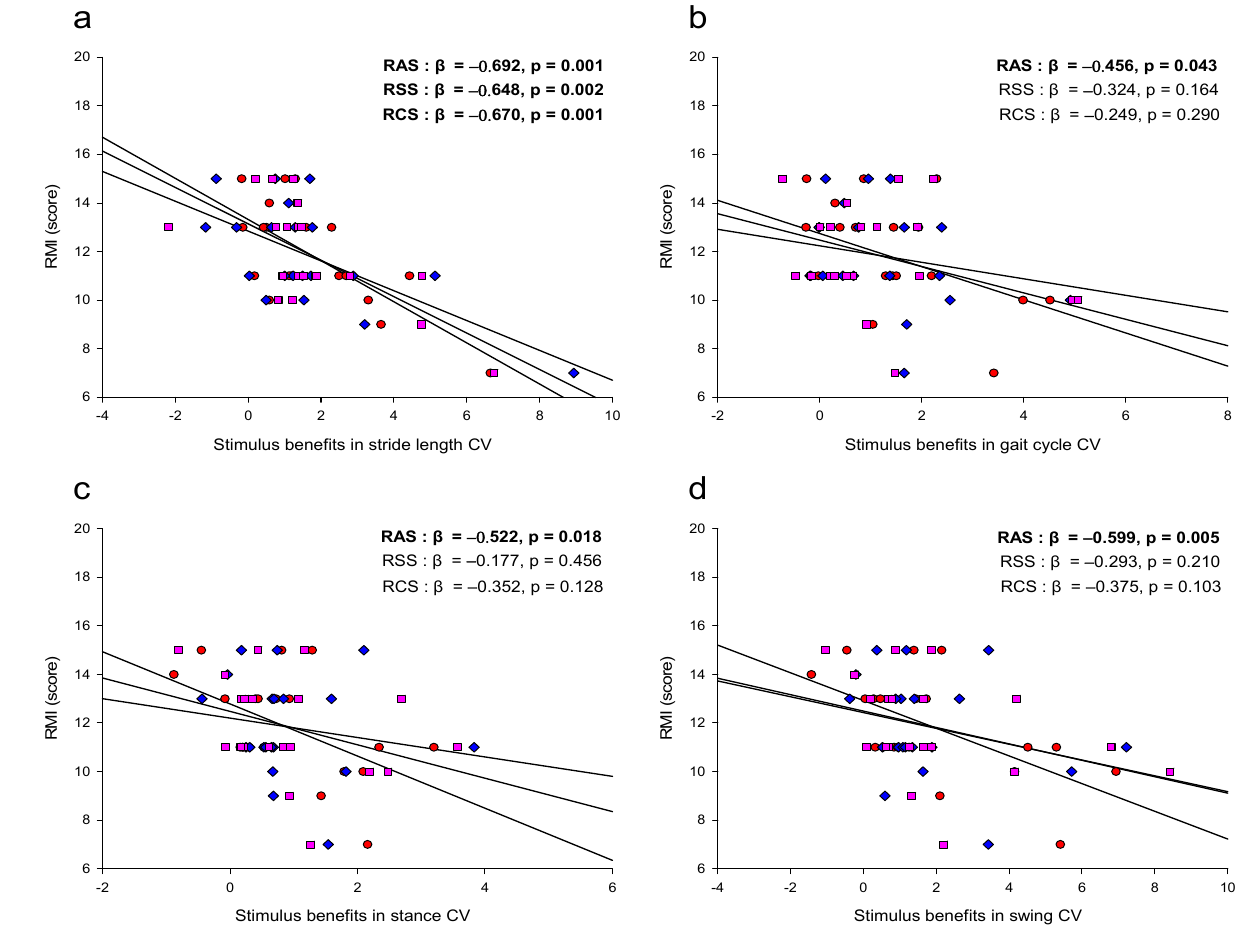
Figure 6. Association between RMI and stimulus benefits in gait variability. ( a ) stimulus benefits in stride length CV; ( b ) stimulus benefits in gait cycle CV; ( c ) stimulus benefits in stance CV; ( d ) stimulus benefits in swing CV. Bold marks indicate significant differences ( p < 0.05). The stimulus benefit in gait variability is normal condition minus stimulus condition. The red scatter plot is the stimulus benefit for RAS, blue is the stimulus benefit for RSS, and purple is the stimulus benefit for RCS.